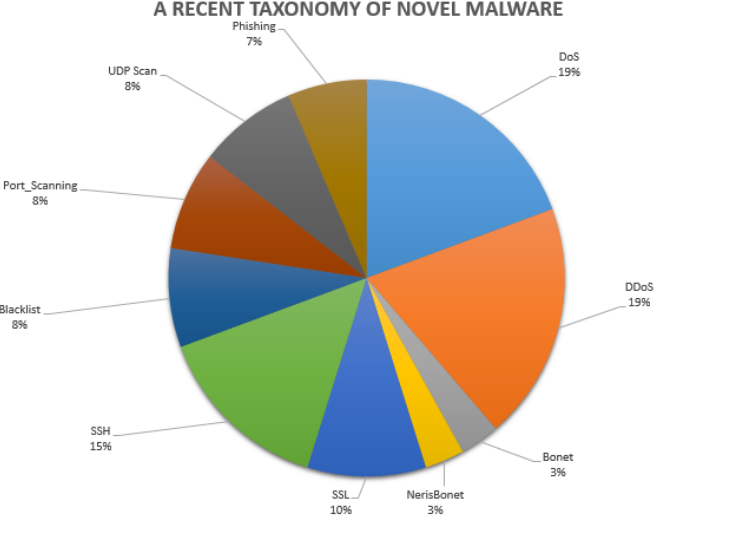
Figure 3. Recent malware detected in the current NIDL.